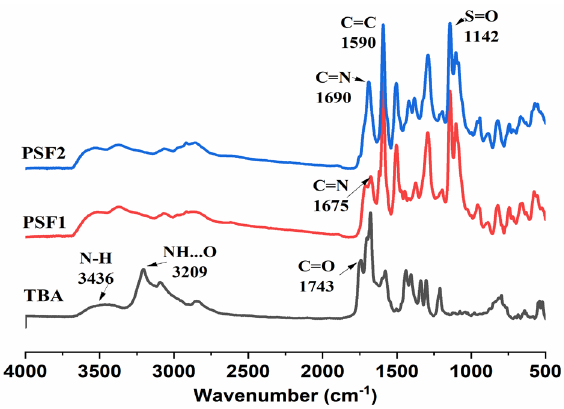
Figure 2. FT-IR of TBA, PSF1, and PSF2.